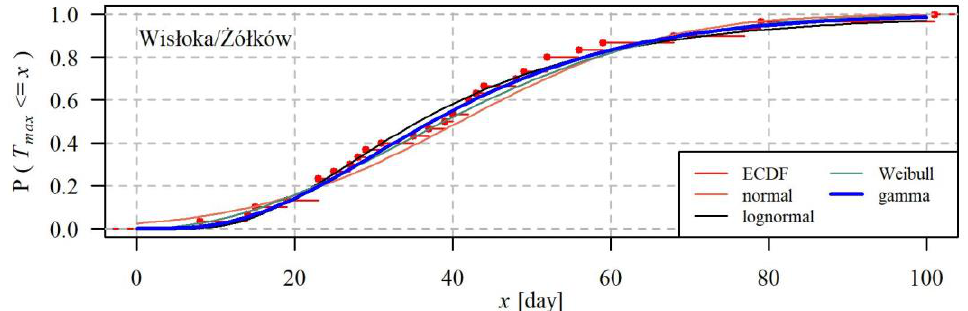
Figure 8. Empirical cumulative distribution ECDF and the normal, lognormal, gamma and Weibull probability distributions of variable T max at the Żółków gauging cross - section of the Wisłoka river.